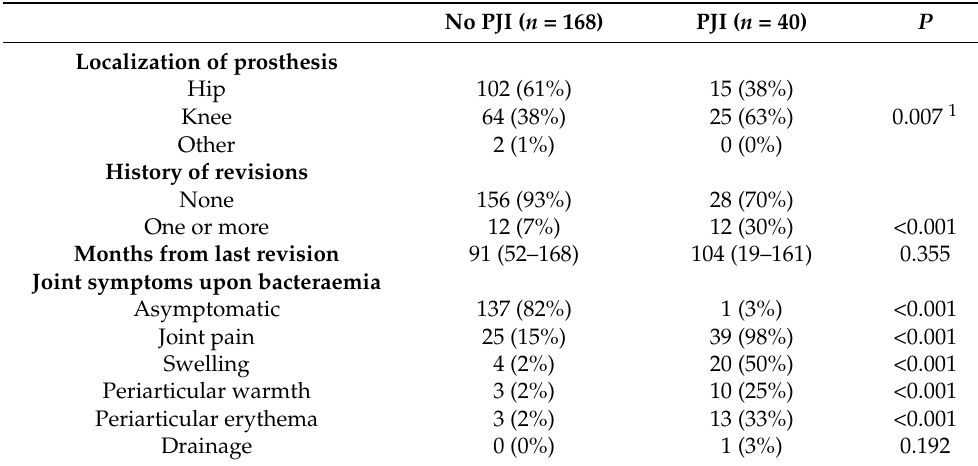
Table 1. Orthopaedic characteristics of the joint